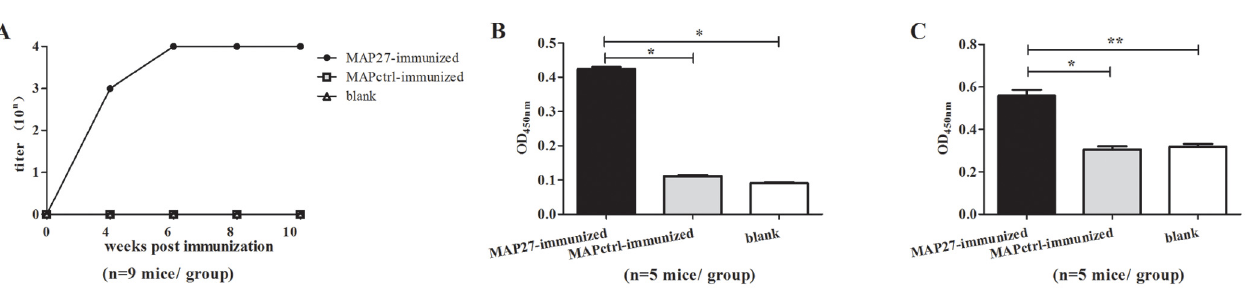
Fig 2. BALB/c mice immunized with MAP27 produced anti-MAP27, anti-PGN and anti- S . aureus antibodies. (A) Titers of anti-MAP27 serum during the period of immunization. 96-well plates were coated with MAP27. Serum samples from mice immunized with MAP27, MAPctrl or blank were pooled and added in a 10-fold serial dilution, followed by incubation with HRP-conjunctive goat anti-mouse IgG. (B) Sera from MAP27-immunized mice bind to PGN after the fifth MAP immunization. (C) Sera from MAP27-immunized mice bind to S . aureus after boosting with heat-killed S . aureus . For ELISA assays in panel B and C, 96-well plates were coated with PGN or sonicated S . aureus fragments. Serum samples were added in a 1/200 dilution as primary antibodies, followed by incubation with HRP-conjunctive goat anti-mouse IgG. The absorbance was measured at OD 450nm . The results are presented as means ± SEM. * P < 0.05, ** P < 0.01, n = 5 – 9